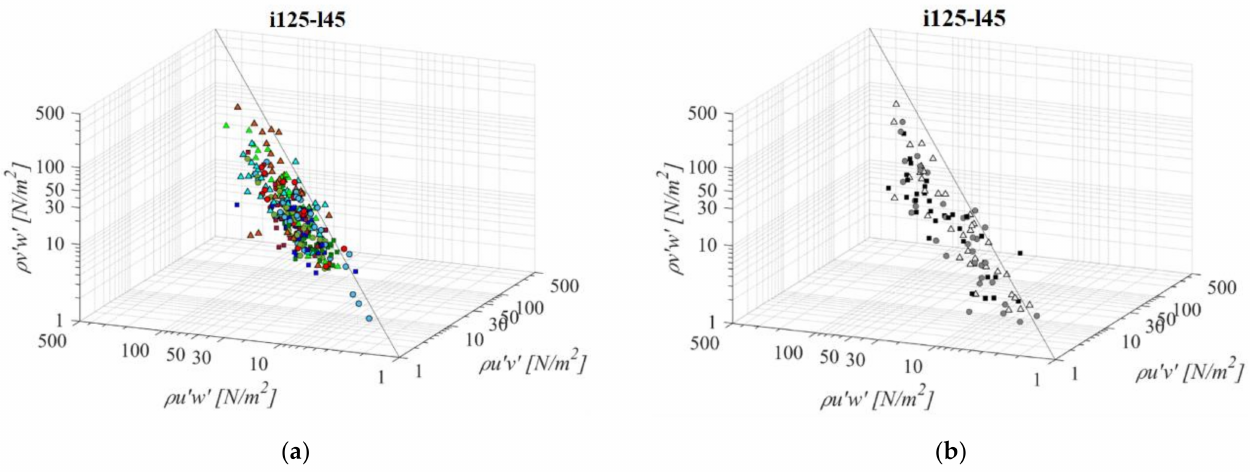
Figure 5. 3D scatterplot of concurrent RSS components for the i125l45 fishway configuration: ( a ) pool-orifice type fishway and ( b ) vertical slot